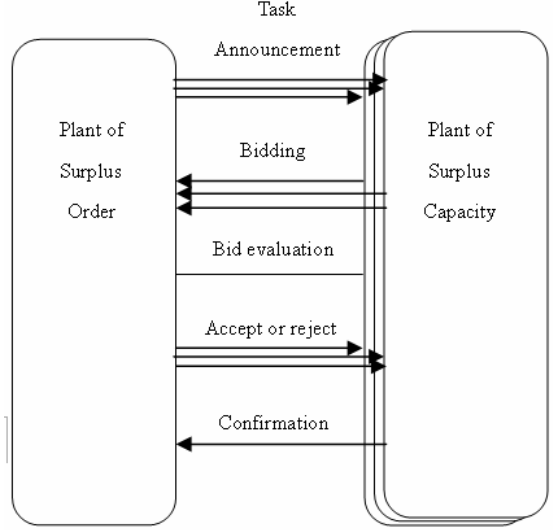
Fig. 1.1. Cooperation mechanism for multi-agent cooperation in the manufacturing network